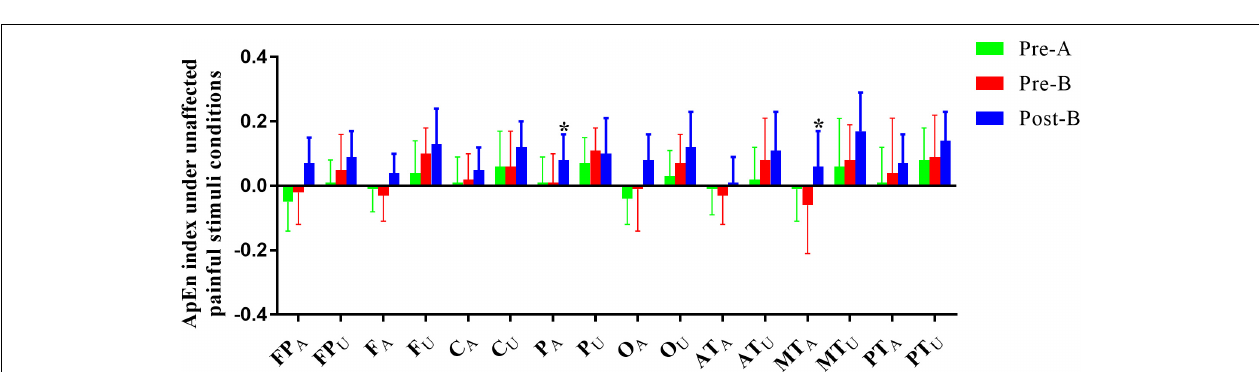
FIGURE 3 | ApEn index under the affected painful-stimuli condition.